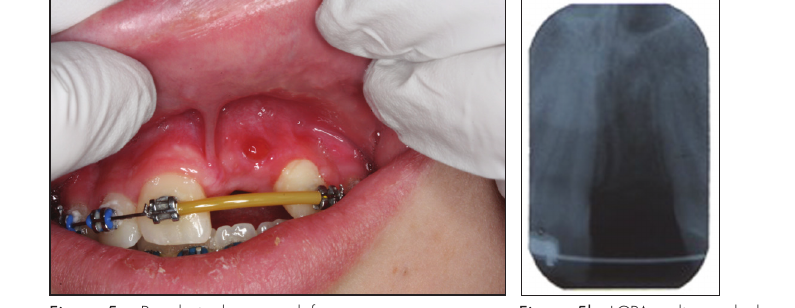
Figure 5b. LCPA radiograph demonstrating continued presence of residual hard tissue and radio-opaque material in the upper left central incisor region.